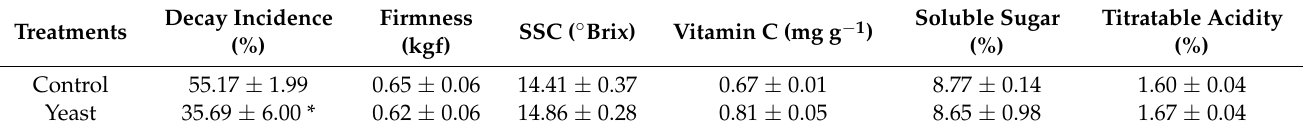
Table 2. Treatments on soft-ripe quality of kiwifruit.